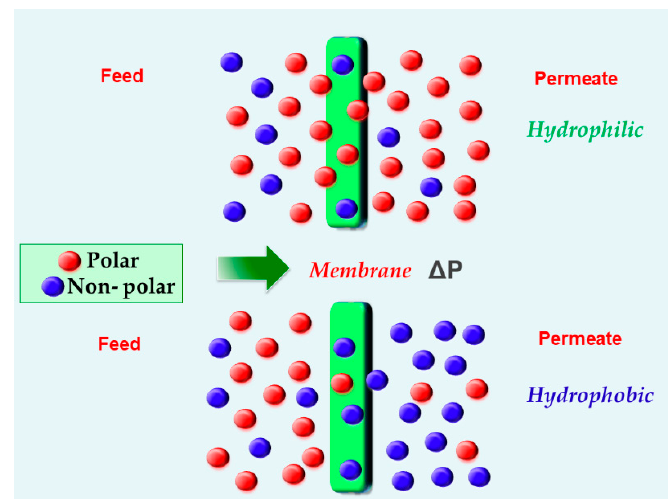
Figure 1. Graphical depiction of the preferential transport of hydrophilic and hydrophobic membranes.